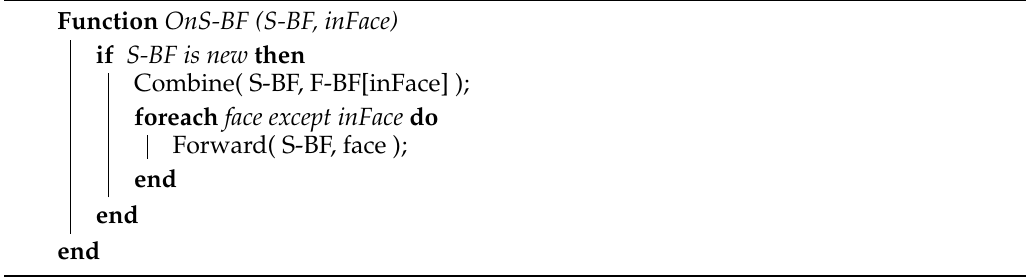
Figure 3. An example of building an F-BF. A node has n F-BFs, where n is the number of faces, and the F-BF which dedicated for face i is denoted as F-BF[i]. Whenever a new S-BF arrives, the F-BF of the incoming face is updated by bitwise-ORing the incoming S-BF and the existing F-BF. Algorithm 1: Procedure for receiving Bloom